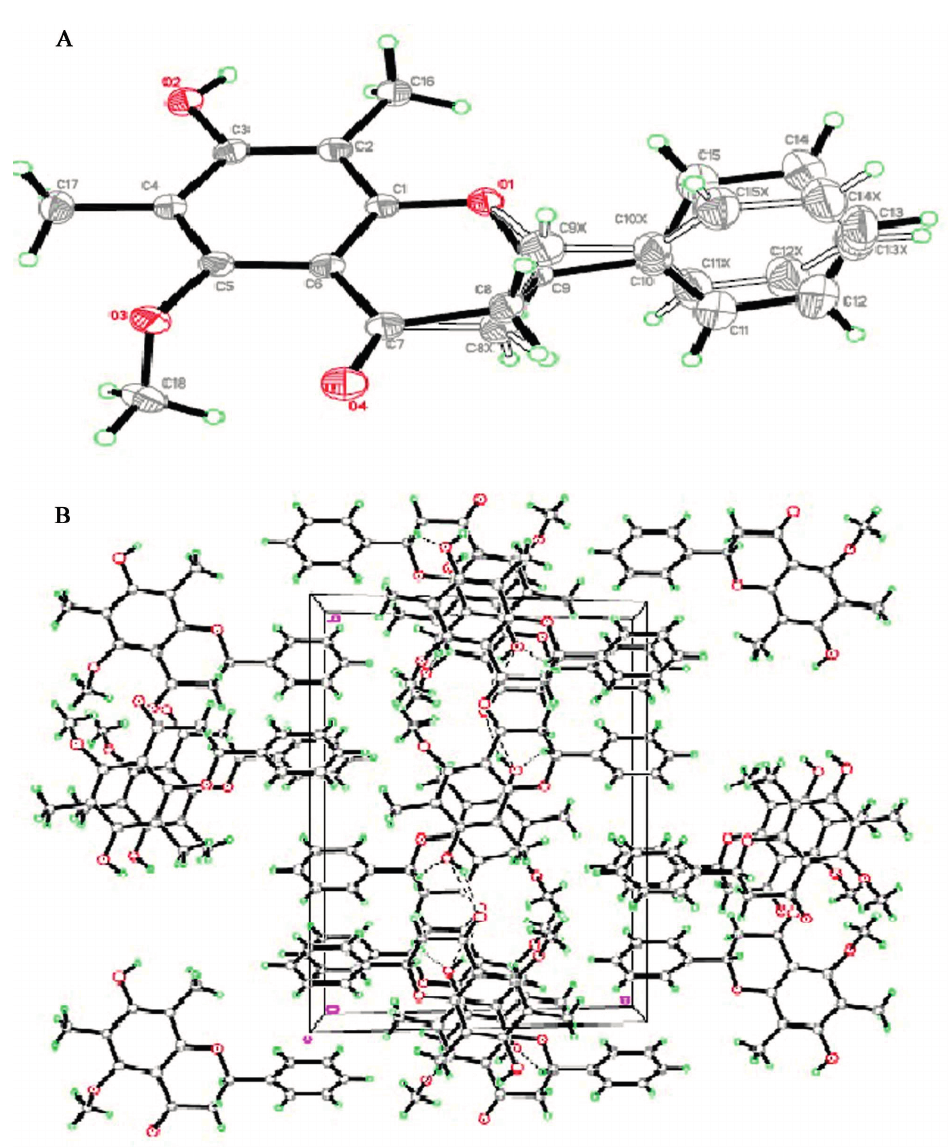
Figure 6. ( A ) Stereochemical structures of (2 S )-7-Hydroxy-5-methoxy-6,8-dimethyl flavanone; ( B ) Crystal packing of (2 S )-7-Hydroxy-5-methoxy-6,8-dimethyl flavanone. The molecules packed in monoclinic crystal system through intermolecular hydrogen bonds shown as dashed